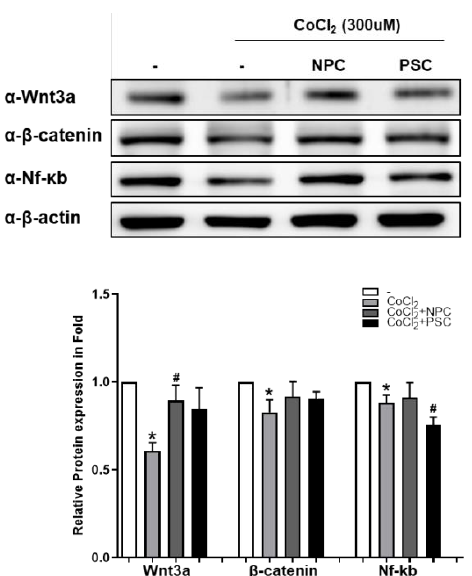
Figure 5. Wnt/ β -catenin and Nf-kb during recovery process of damaged R28 cells. After being co-cultured with NPCs or hPSCs, R28 were exposed to CoCl 2 (300 µ M). After incubation for 24 h, Western blotting analyses were performed. The results are expressed as the mean ± standard error of the mean (SEM) (* p < 0.05 vs. the control; # p < 0.05 vs. CoCl 2 ).